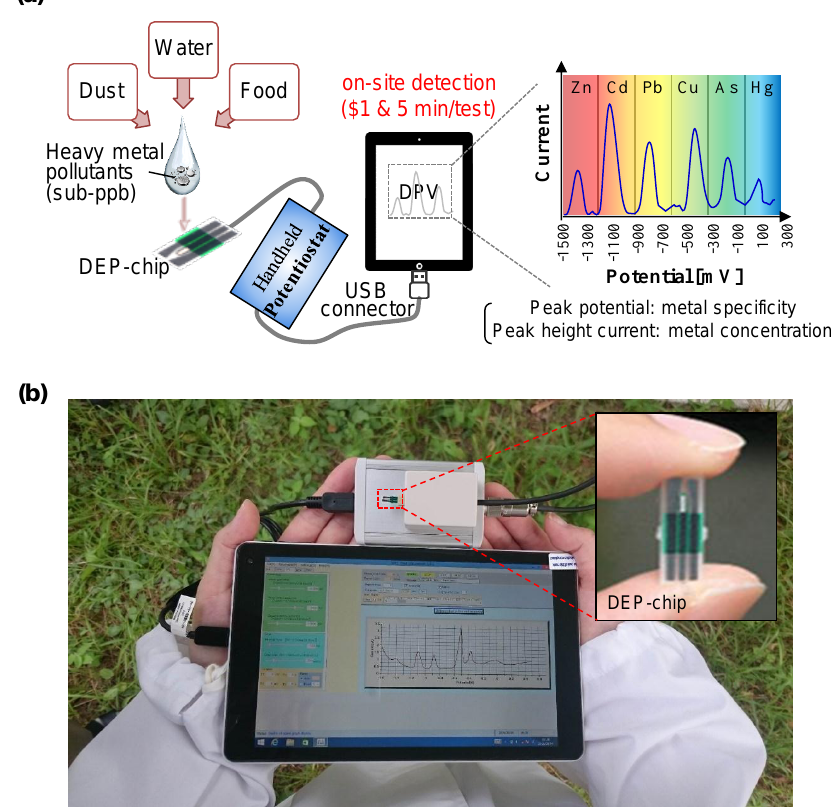
Figure 1. “DEP-On-Go sensing” concept. Schematic representation of the work flow ( a ) and photographs ( b ) of the sensing platform for the on-site and rapid detection of heavy metal pollutants directly from environmental samples.